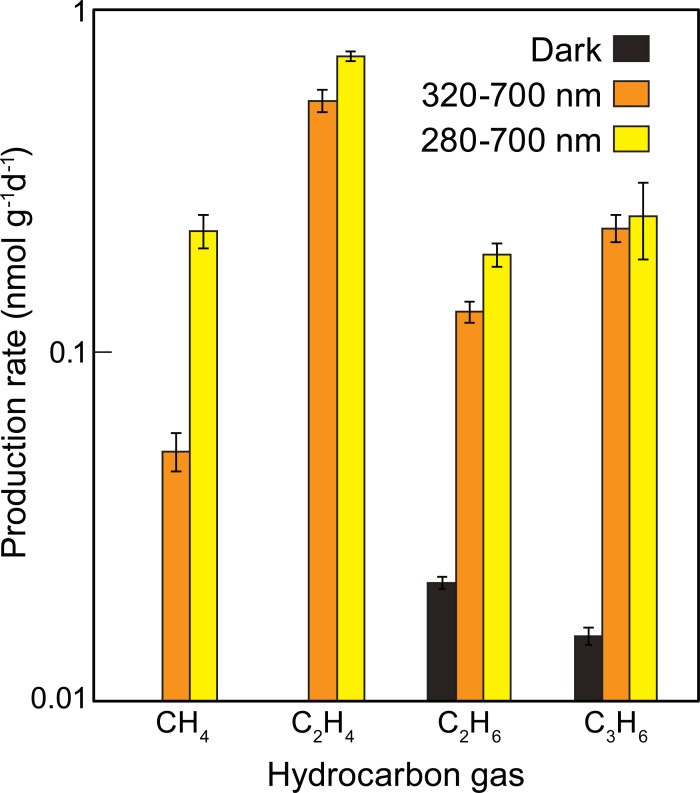
Effect of spectral irradiance on hydrocarbon gas production from LDPE.Production rates of hydrocarbon gases (CH4, C2H4, C2H6 and C3H6) from virgin LDPE pellets kept in the dark, exposed to full solar radiation (280–700 nm) or to solar radiation filtered for UVB (320–700 nm). Error bars represent the standard deviation of triplicate samples.